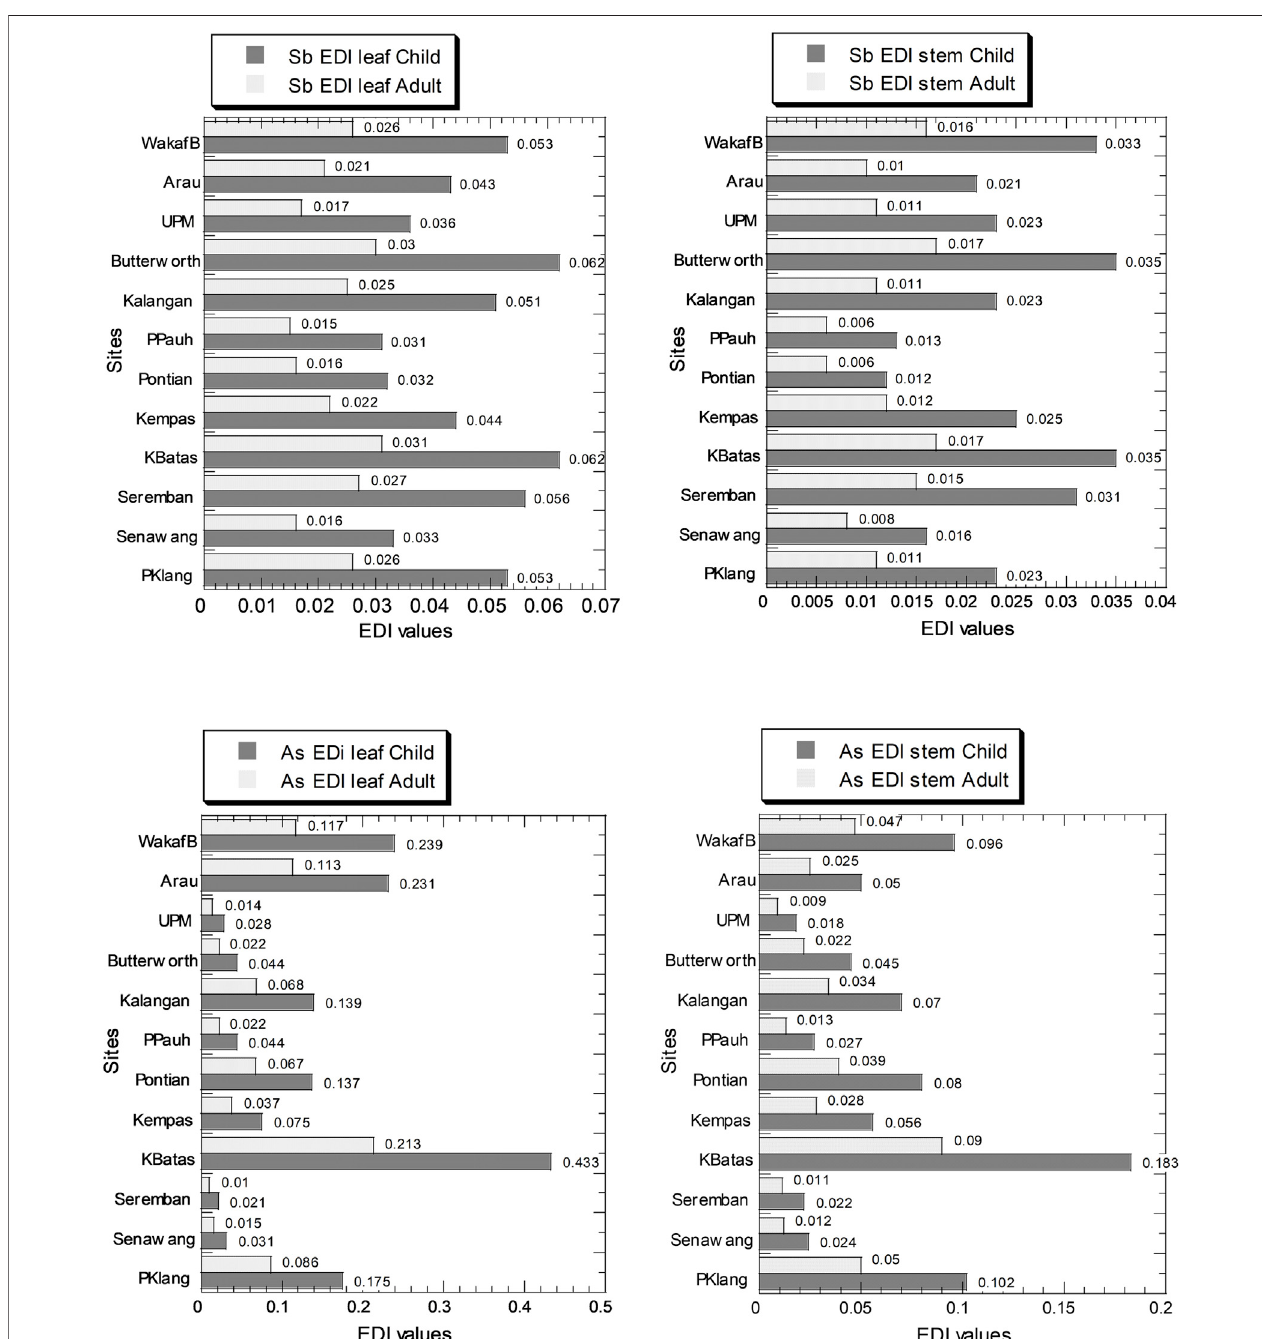
FIGURE 3 | Estimated dietary intake (EDI) values (µg/kg wet weight/day) of Sb and As in the leaves and stems of Centella asiatica collected from 12 sampling sites (numbers in white circles (1 – 12) in Figure 1 ; S1 – S12 in Supplementary Table S1 ) in Peninsular Malaysia. The X -axes are based on a linear scale.